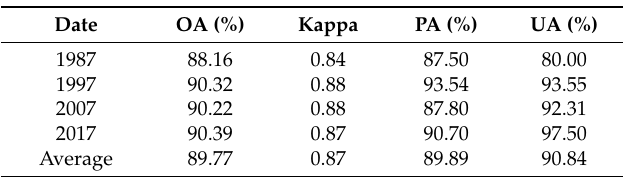
Table 2. A summary of the assessment of the urban area classification’s accuracy. UA, user’s accuracy; PA, producer’s accuracy; OA, overall accuracy.